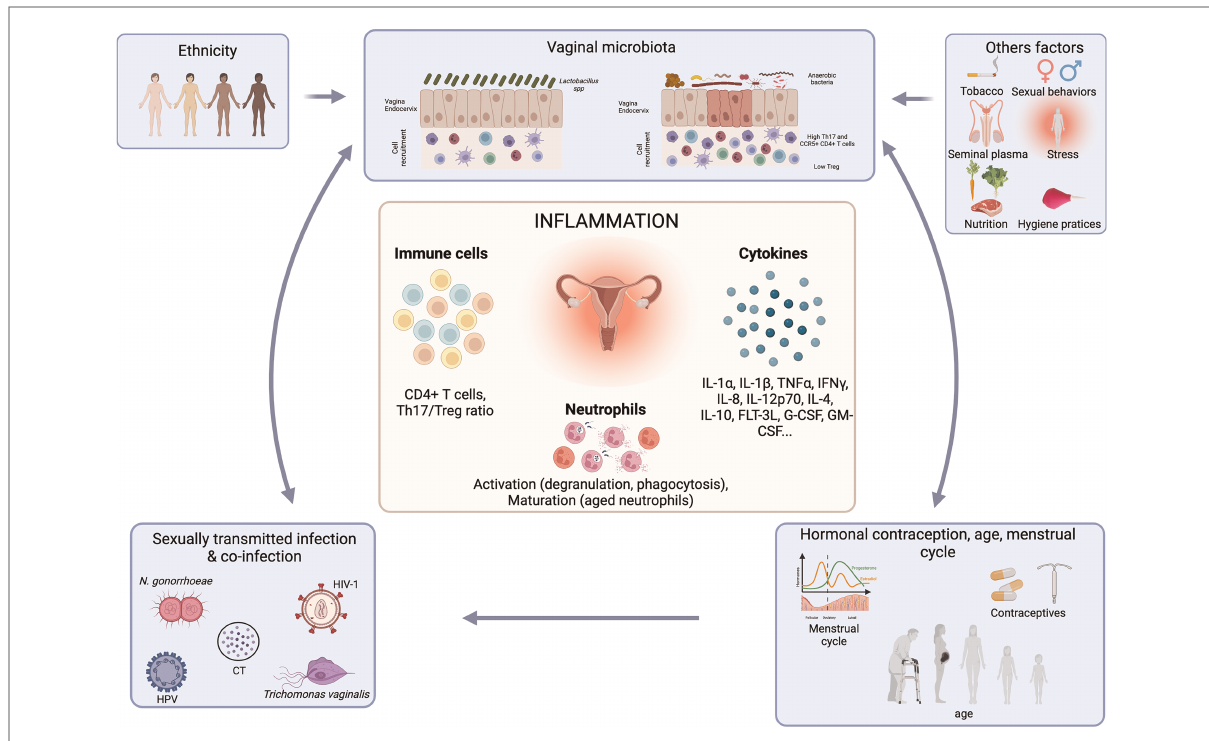
FIGURE 2 Association between factors affecting the vaginal microbiota and the effect on in fl ammation. The vaginal microbiota can be in fl uenced by numerous factors including sexually transmitted infection, hormonal contraception, menstrual cycle, ethnicity, sexual behaviors, hygiene practices, stress, nutrition etc. Those factors by in fl uencing the vaginal microbiota will affect the FRT in fl ammation including cytokine production, T cell recruitment and neutrophil activation and maturation. Created with